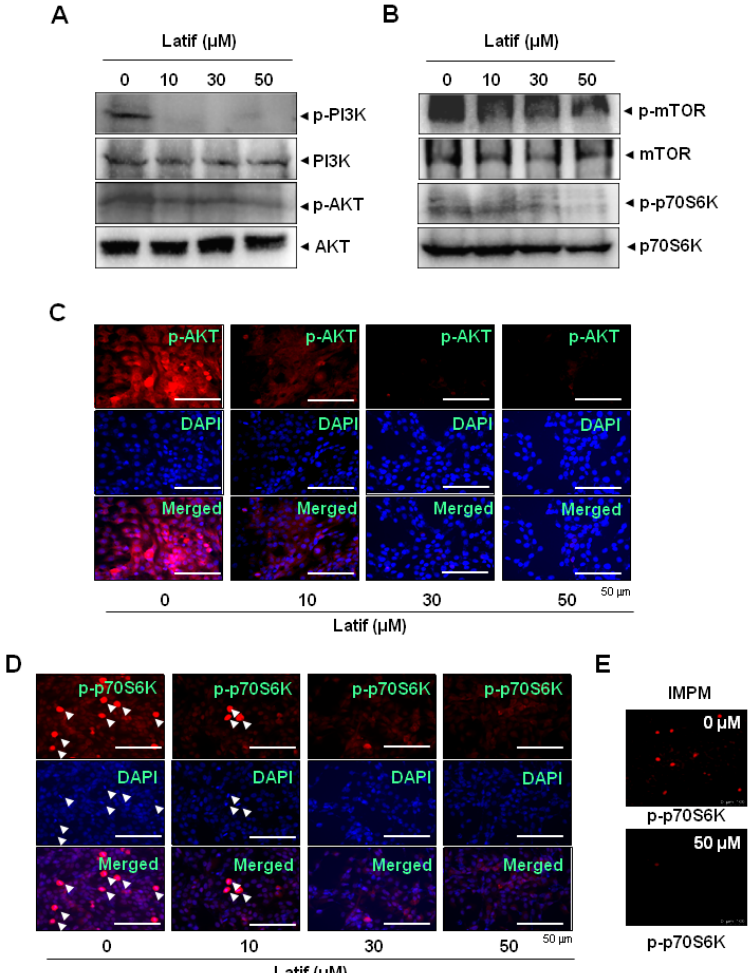
Figure 4. Effects of Latif on the AKT pathway in human YD-10B OSCCs. ( A , B ) Amounts of 10, 30, and 50 μ M Latif was treated for 24 h in YD-10B OSCCs, and then phospho-PI3K (p-PI3K), PI3K, phospho-AKT (p-AKT), AKT ( A ), phospho-mTOR (p-mTOR), mTOR, phospho-p70S6K (p-p70S6K), and p70S6K ( B ) were analyzed using Western blot analysis. β -actin level was detected as a loading control. ( C – E ) The cellular expression of p-AKT ( C ) and p-p70S6K ( D , E ) was analyzed using an immunofluorescence assay and images were observed using a fluorescence microscope ( C , D ) and validated using the intravital multi-photon microscope system (IMPM) for p-p70S6K ( E ). DAPI (blue) was used to stain the nucleus. Arrowheads: p-p70S6K- and DAPI-positive cells. Data are representative of the results of three